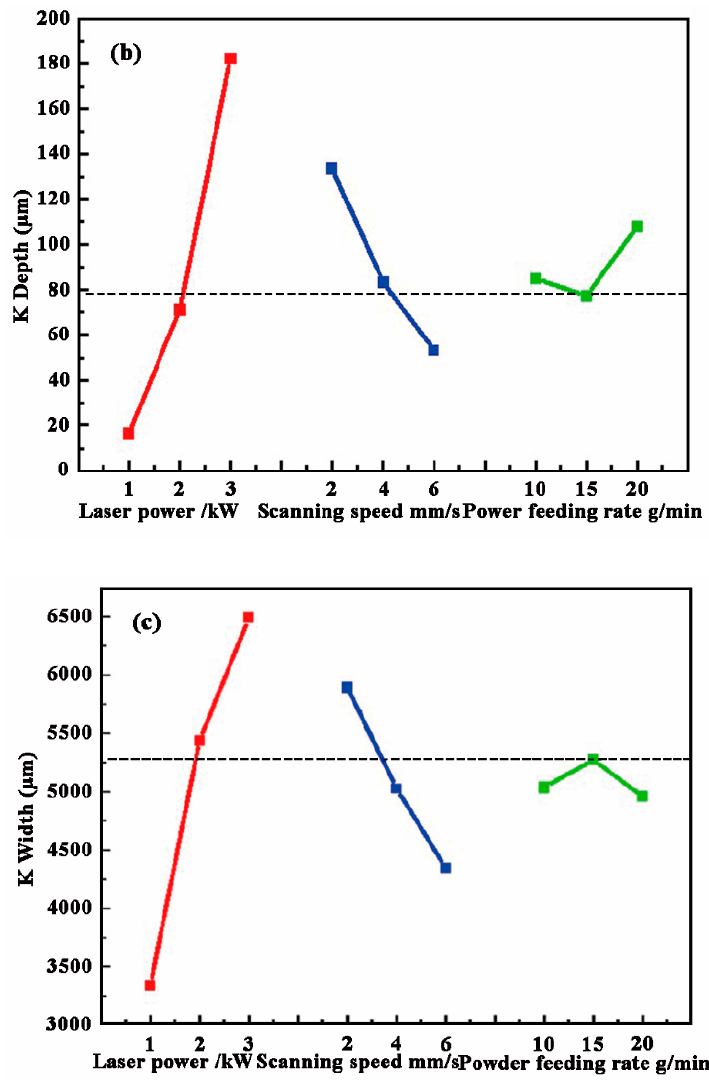
Figure 5. Effect of process parameters (laser power: red, scanning speed: blue and feeding rate: green) on the ( a ) height, ( b ) depth, and ( c ) width of the cladding layer.